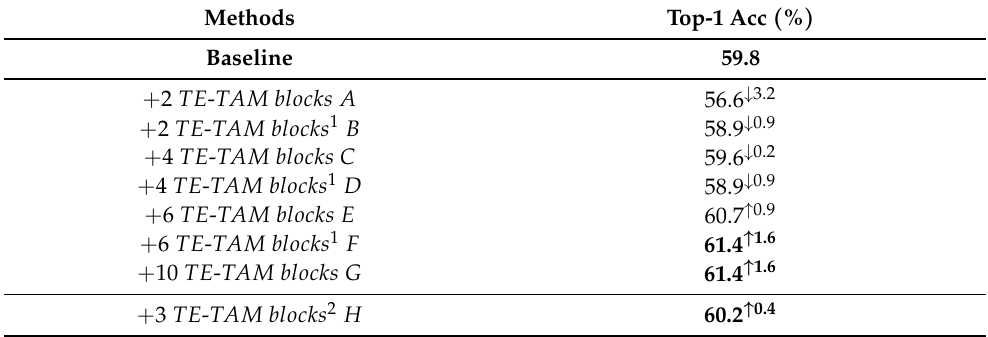
Table 1. Comparison of Top-1 Acc with blocks of different stacked numbers and inserted positions.